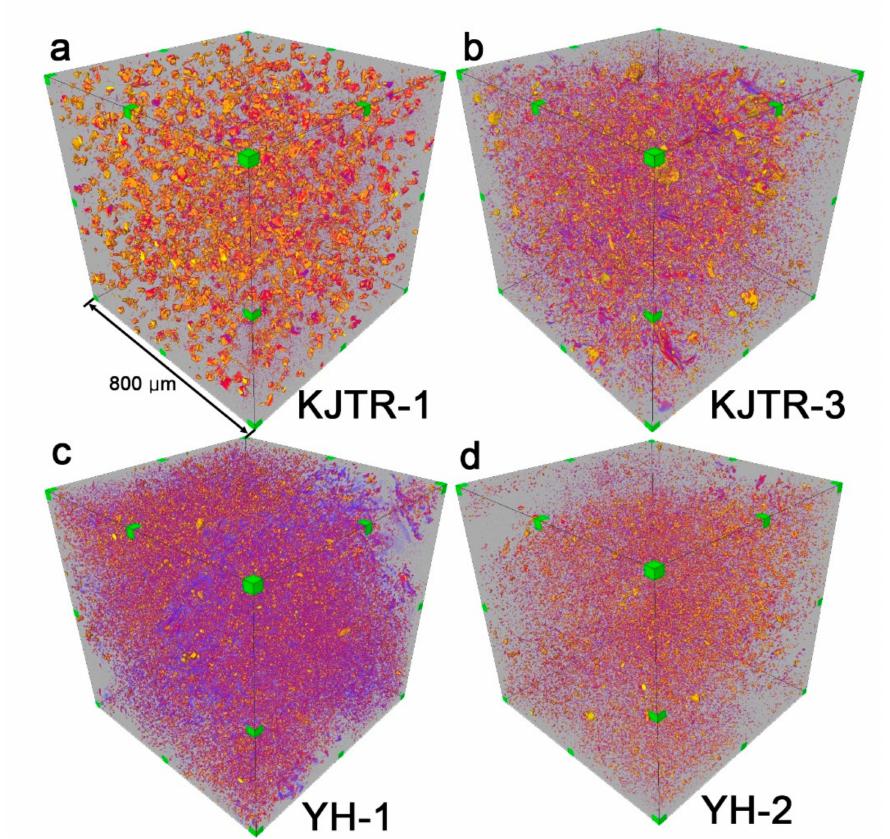
Figure 4. Synchrotron CT image of fault rock samples. After the image filtering process, the temperature type filter was used, adjusting the filter value so that the grains inside the fault rock could be easily seen. ( a ) KJTR-1 (cataclasite) and ( b ) KJTR-3 (fault gouge), from the Ulsan fault; ( c ) YH-1 (fault gouge) and ( d ) YH-3 (cataclasite), corresponding to the Yangsan fault, show di ff erent